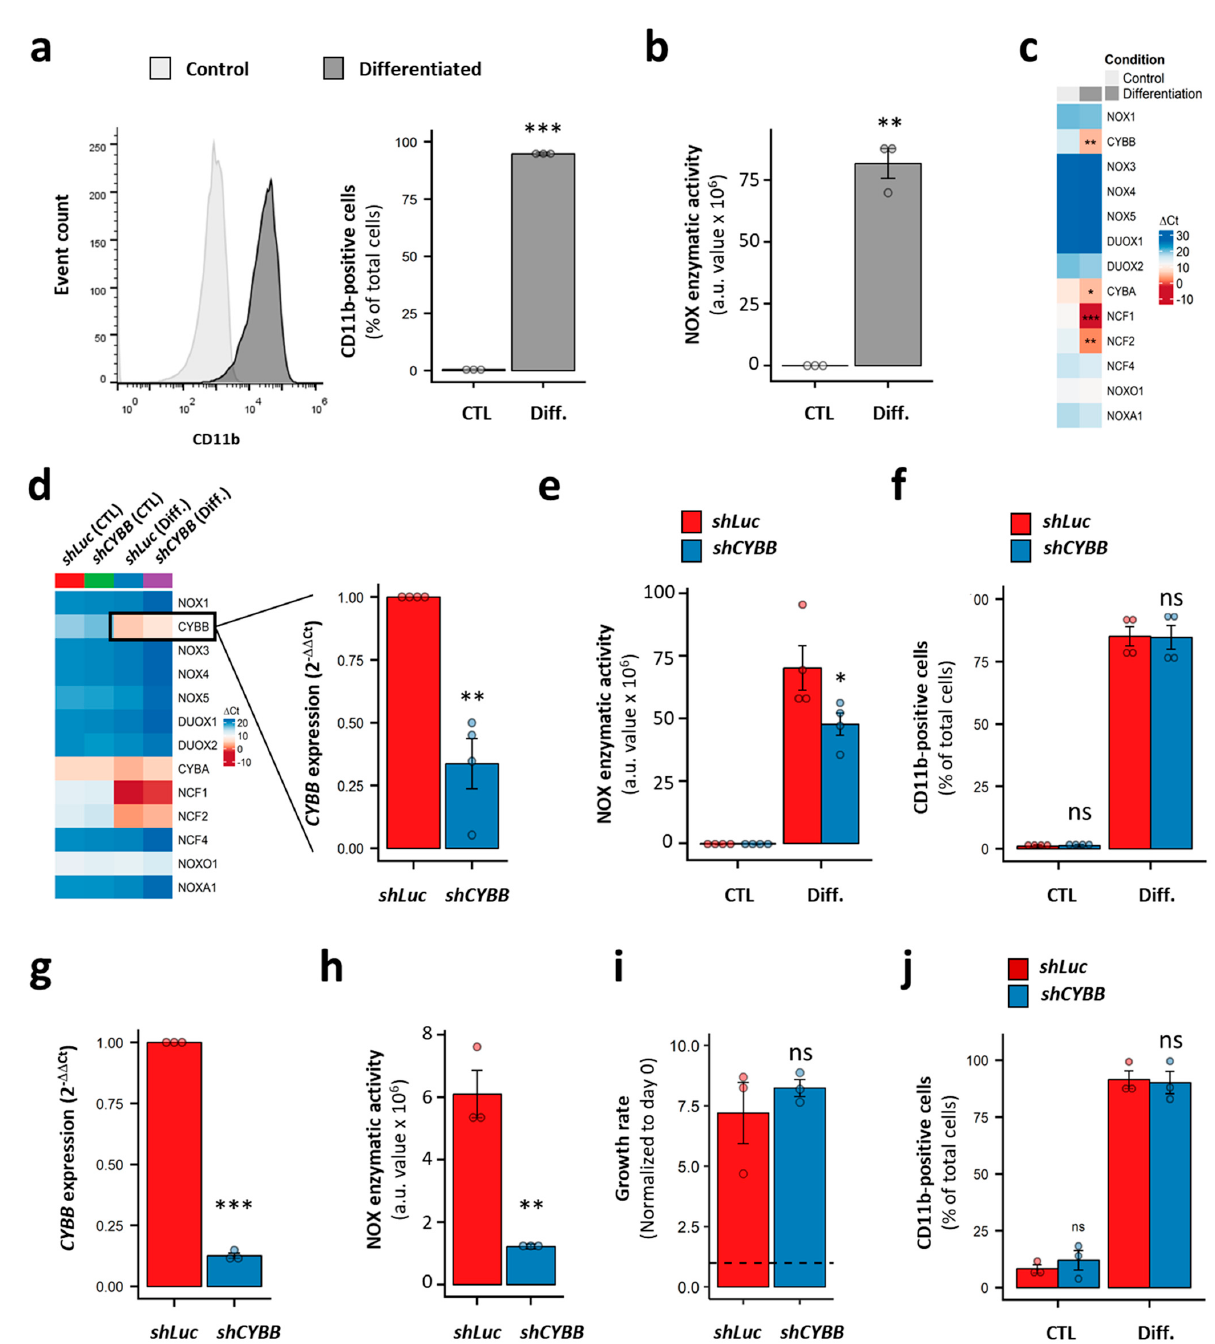
Figure 6. Effect of CYBB knockdown (KD) on the proliferation and differentiation of AML cell lines. ( a ) The expression of CD11b in HL-60 cells with and without differentiation. ( b ) The PMA-induced NOX activity in HL-60 cells, with and without differentiation. ( c ) The NOX expression profile in HL-60 cells, with and without differentiation. ( d ) The effect of CYBB KD on the NOX expression profile in HL-60 cells, with and without differentiation. ( e ) The effect of CYBB KD on PMA-induced NOX activity in HL-60 cells, with and without differentiation. ( f ) The effect of CYBB KD on CD11b expression in HL-60 cells, with and without differentiation. The CD11b expression is reported as percentage of positive cells. ( g – j ) The effect of CYBB KD on CYBB expression ( g ), PMA-induced NOX activity ( h ), the proliferation ( i ) and PMA-induced differentiation ( j ) of THP-1 cells. The proliferation of the THP-1 cells was assessed after three days of culture, and the proliferation rate is reported as a ratio to day 0. Student’s t-test, followed by BH adjustment, was used for the pairwise comparisons. (ns: not significant; *: p < 0.05; **: p < 0.01; ***: p < 0.001). CTL: control; Diff.: after differentiation; Luc: luciferase; a.u.: arbitrary